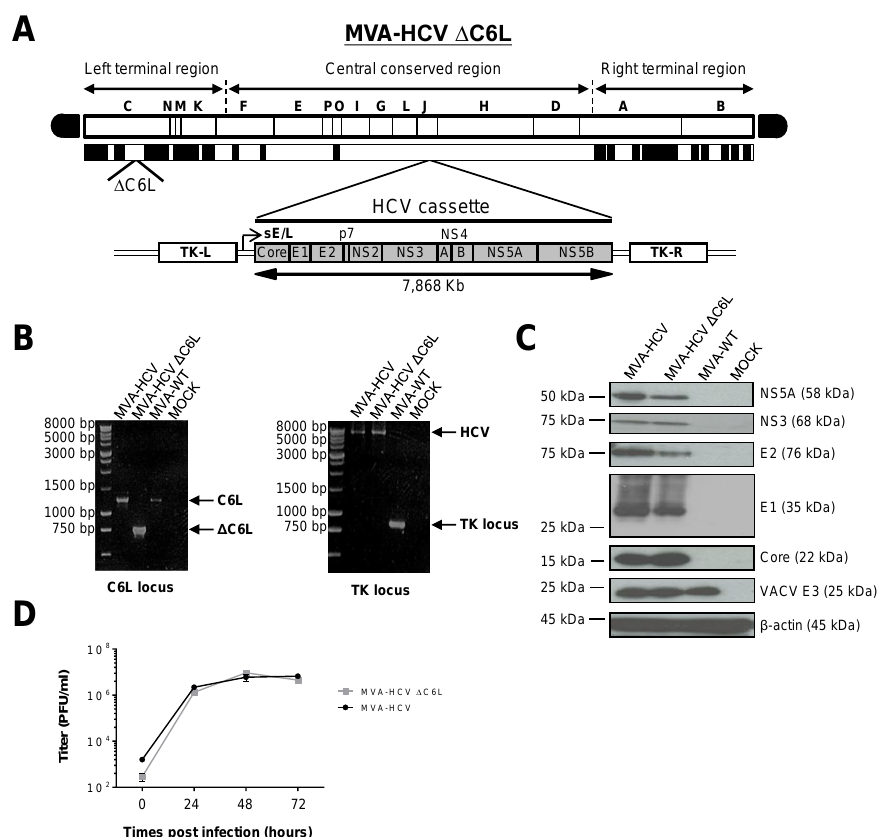
Figure 1. Generation and in vitro characterization of modified vaccinia virus Ankara (MVA)-hepatitis C virus (HCV) ∆ C6L. ( A ) Scheme of the MVA-HCV ∆ C6L deletion mutant genome map. The different regions of the MVA vector are shown in capital letters. Below the map, the deleted or fragmented vaccinia virus (VACV) genes are depicted as black boxes, with the deletion of C6L being indicated. The organization of the HCV genome (genotype 1a, strain H77), driven by the sE/L VACV promoter and inserted within the VACV thymidine kinase (TK) viral locus (J2R), is indicated. TK-L, TK left; TK-R, TK right. ( B ) Polymerase chain reaction (PCR) analysis of the VACV C6L (left panel) and TK (right panel) loci. DNA products are indicated by an arrow on the right. ( C ) Expression of HCV proteins in DF-1 cells infected with MVA-HCV or MVA-HCV ∆ C6L at 24 h post-infection (hpi). ( D ) Viral growth kinetics in DF-1 cells infected with MVA-HCV or MVA-HCV ∆ C6L. At different times post-infection, cells were harvested and virus titers in cell lysates were determined by plaque immunostaining assay with anti-VACV antibodies. The mean and standard deviation (SD) from two independent experiments are shown. WT—wild-type; PFU—plaque-forming